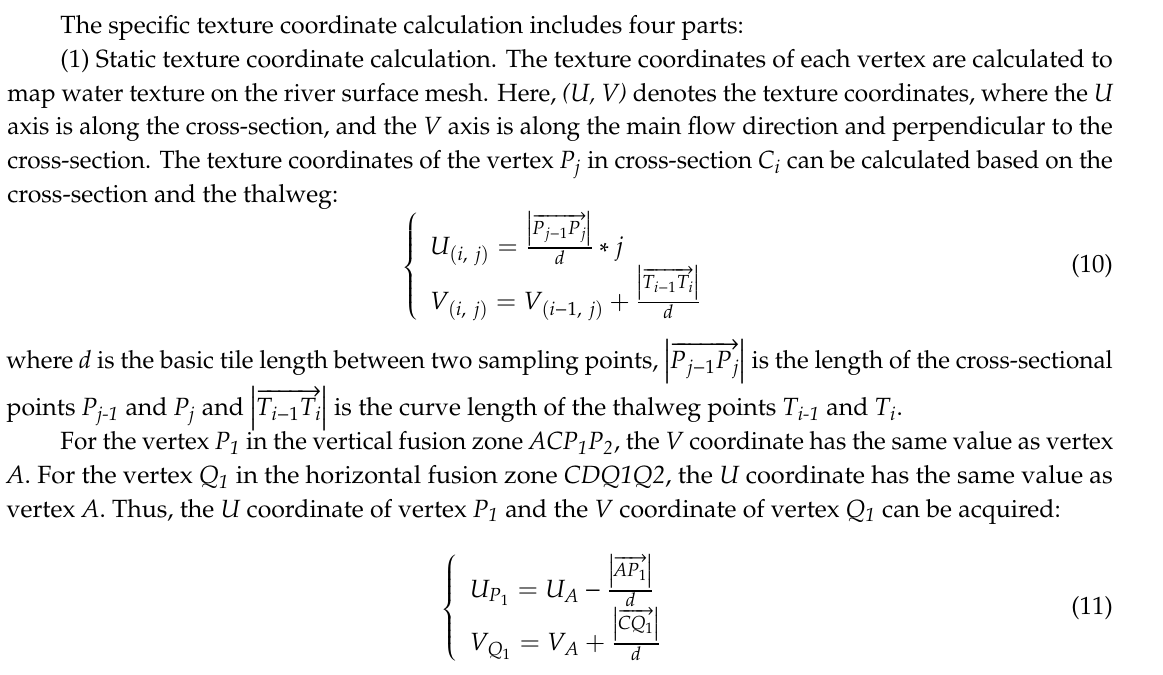
Figure 7. Dynamic texture mapping: ( a ) water surface mesh; ( b ) texture mapping.